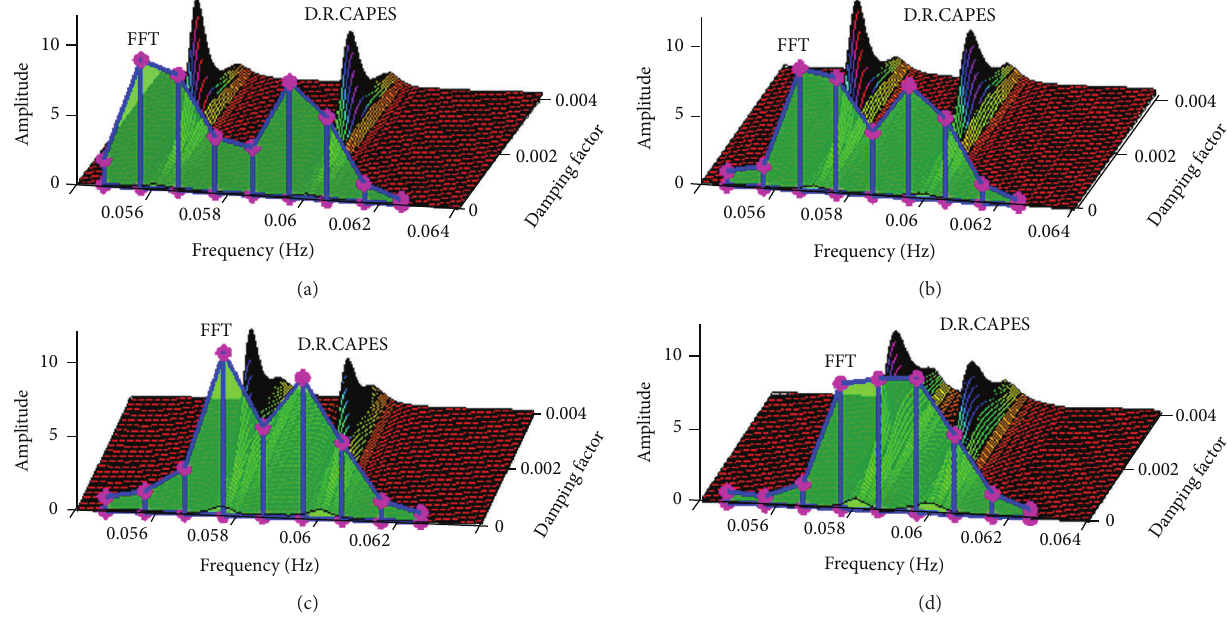
Figure 4: Comparison of frequency resolution of the amplitude spectrum using DR-CAPES and FFT. ((a) 𝑓 1 = 0.052 , 𝑓 2 = 0.06 ; (b) 𝑓 1 = = 0.06 ; (c) 𝑓 = 0.056 , 𝑓 = 0.06 ; (d) 𝑓 = 0.058 , 𝑓 = 0.06 ; FFT spectrum in each figure was formed from data with a length of 1024 0.054 , 𝑓 2 1 2 1 2 and a zero appending technique was used).